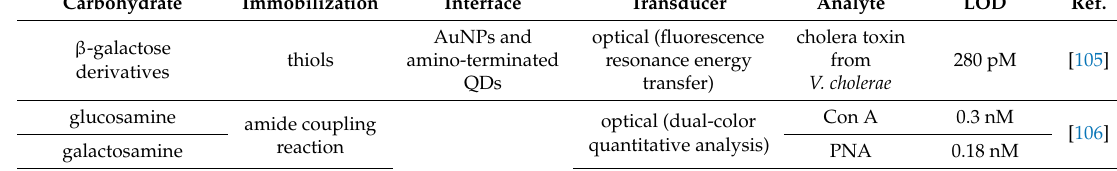
Figure 9. ( a ) Schematic illustration of the rational design for lectin detection; ( b ) construction of a fluorescent array by employing Man-QD 520 (Probe 1), Glu-QD 580 (Probe 2) and Gal-QD 660 (Probe 3) as three signal probes; ( c ) molecular structures of saccharide derivatives for QDs modification. Reproduced with permission from [108]. Copyright Springer, 2018. Table 2. QDs-based glycan nanobiosensors and their characteristics.